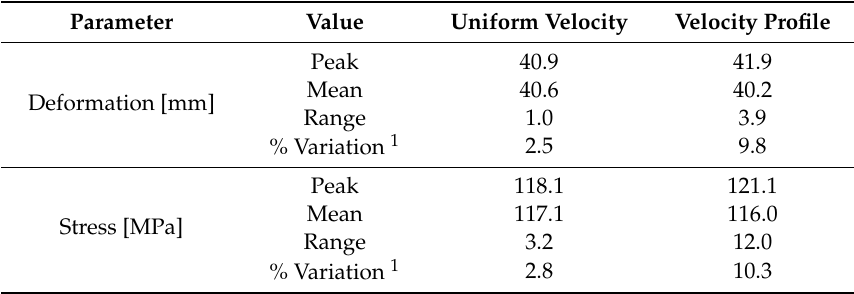
Figure 15. Variation of Blade 1 ( a ) deformation; ( b ) equivalent stress during two rotation cycles. Table 5. Turbine load fluctuations from the last rotation cycle.